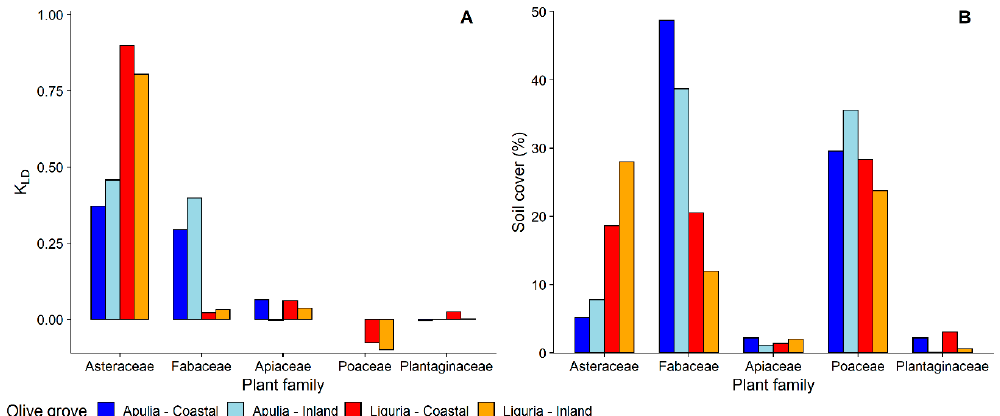
Figure 2. ( A ) Selection of most common plant families by nymphs of Philaenus spumarius —Kullback-Leibler divergence ( D KL ) measure; ( B ) relative percentage of soil cover by most common plant families in Apulia and Liguria olive groves.